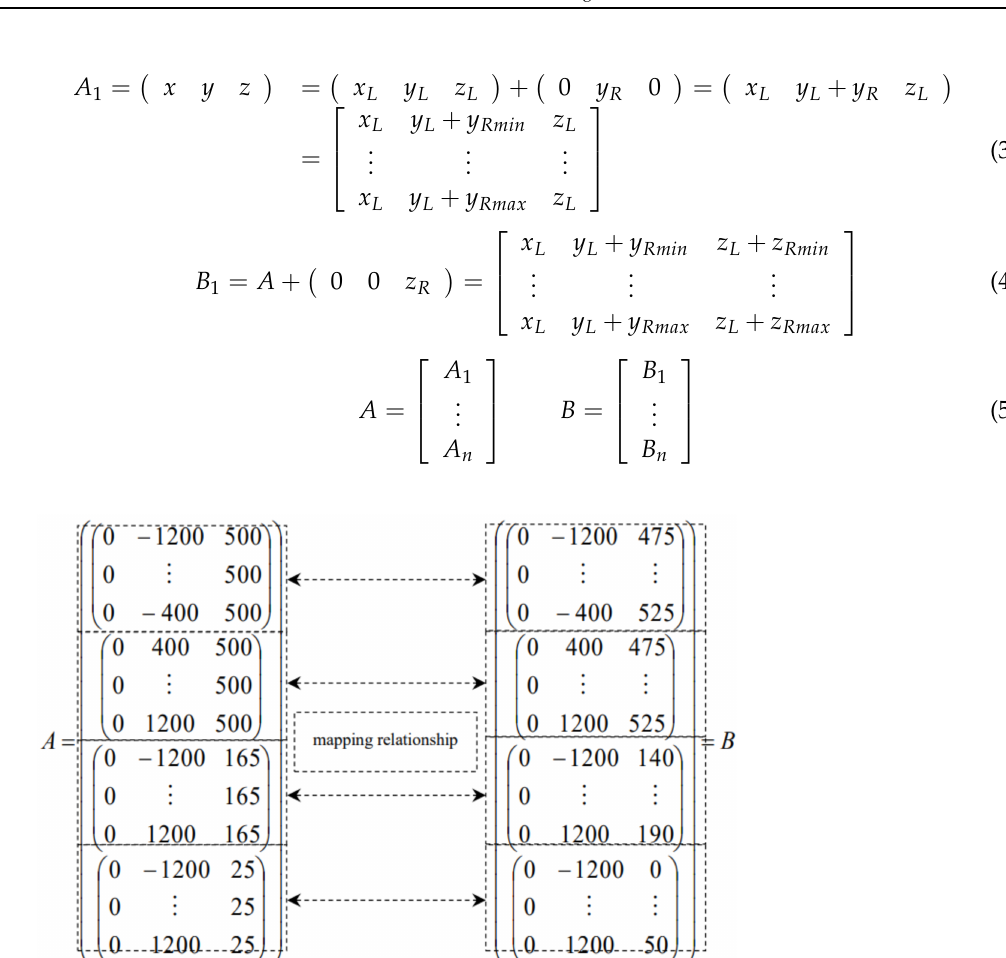
Figure 12. Digital expression model of the rear interface node network of the middle frame